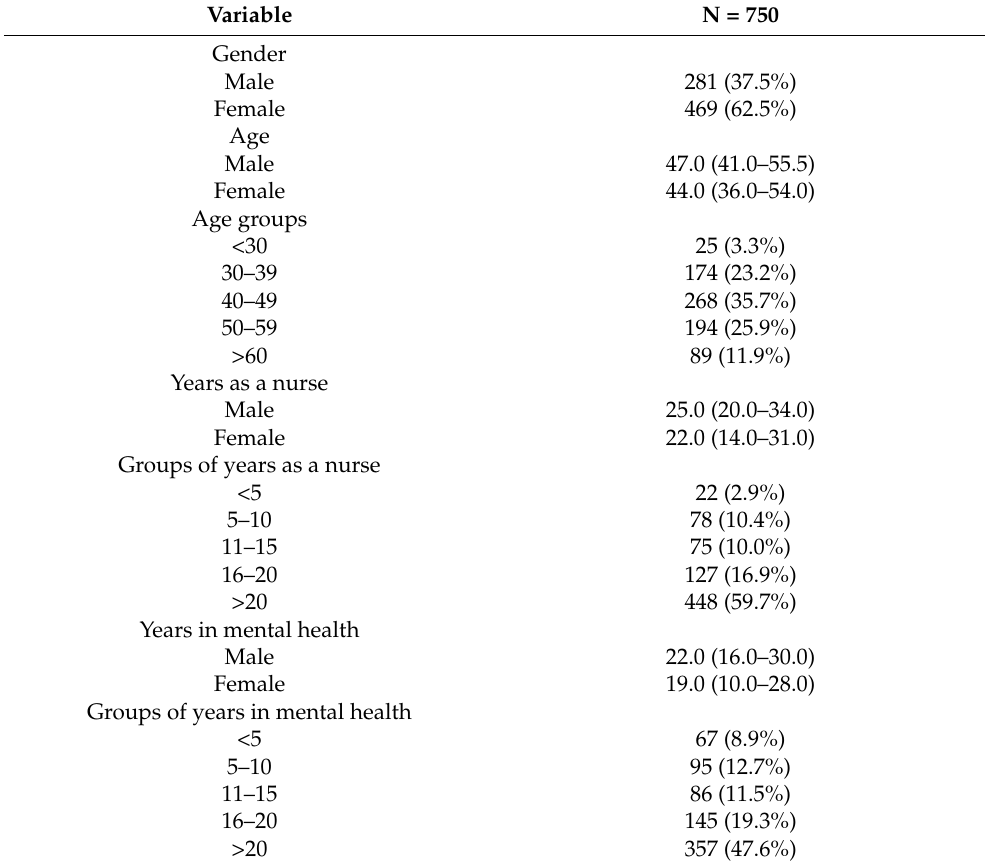
Table 1. Descriptive demographic and work-related data of the